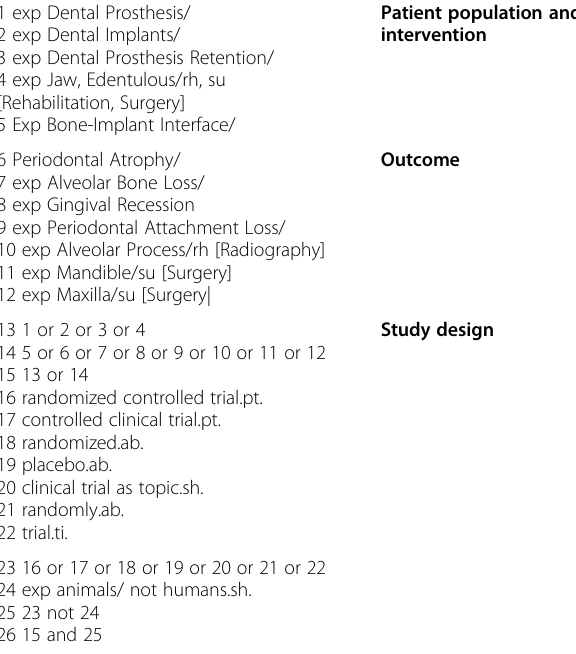
Table 2 Combined Medical Subject Headings (MESH terms) and free-text term search in MEDLINE via OVID